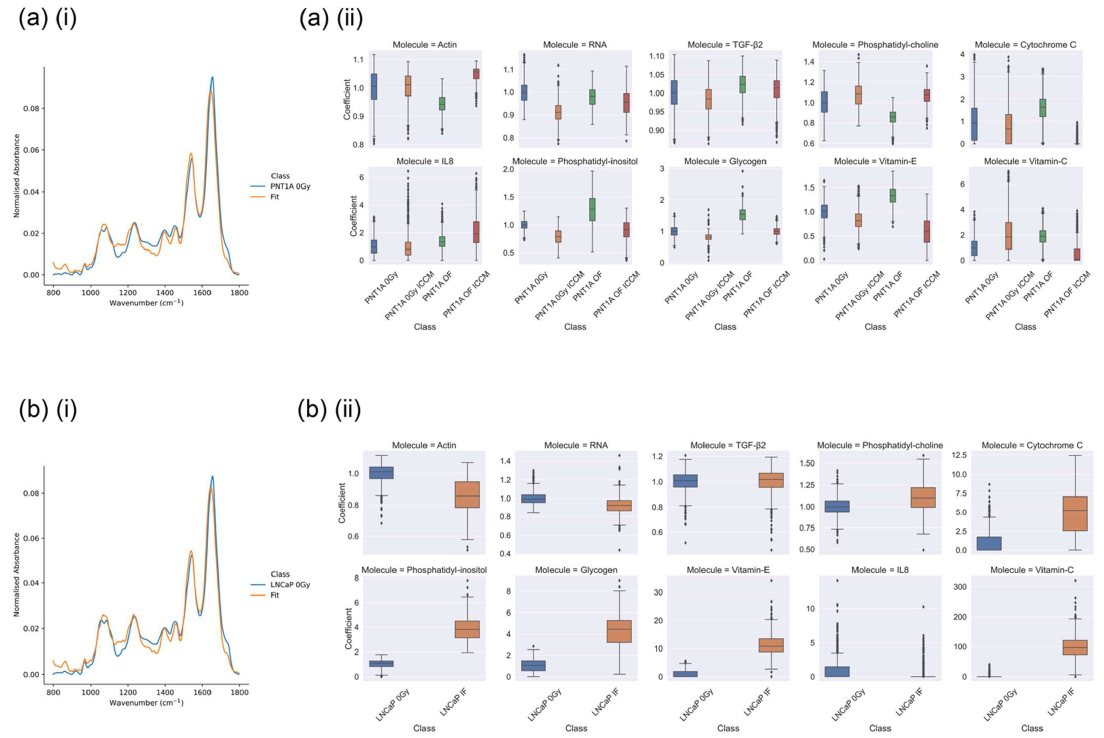
Figure 6 . Examples of (i) fitting of mean spectra and (ii) CLS regression coefficients for (a) PNT1A and (b) LNCaP cell lines in which non-zero regression coefficients were observed ( i ) PNT1A and ( ii ) LNCaP cell lines in the fingerprint region using CLS regression. All regression coefficients have been normalised to the sham-irradiated (0Gy) control for each cell line.